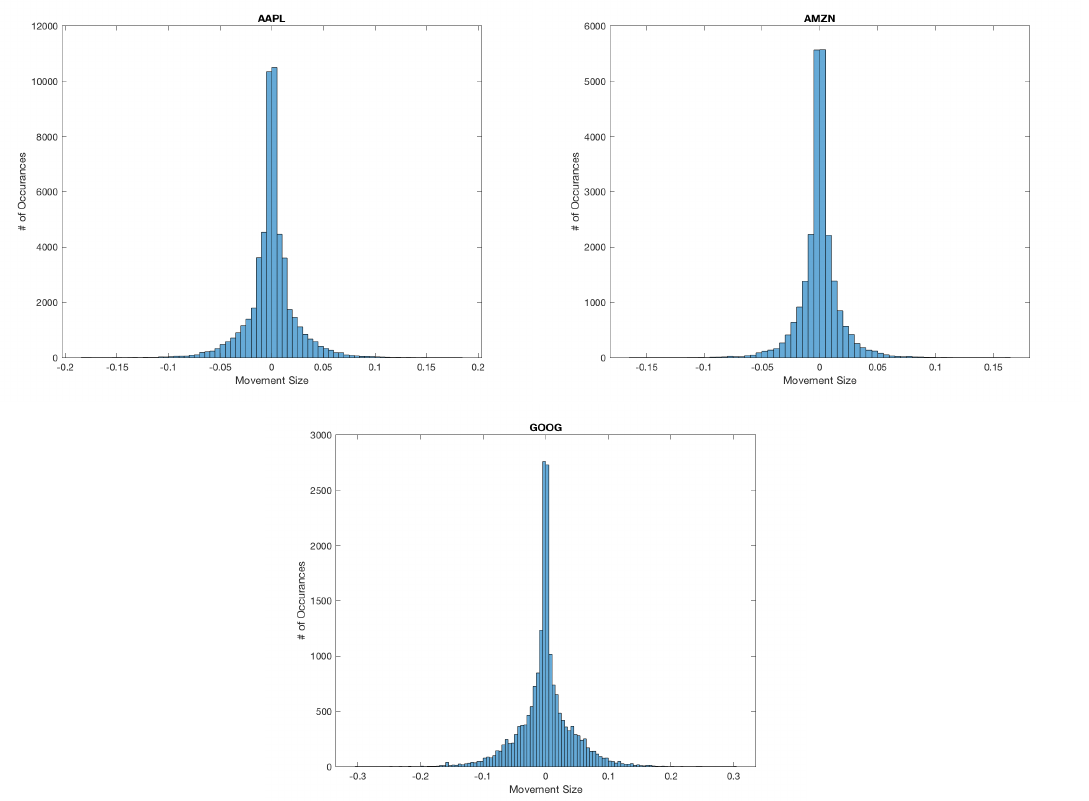
Figure 4. We can see clearly that the change in the mid-price is often larger than a half tick. These mid-price changes make up a significant portion of the actual data, contradicting the assumption needed for the CHPDO model that the mid-price changes occur on average at a half tick size.